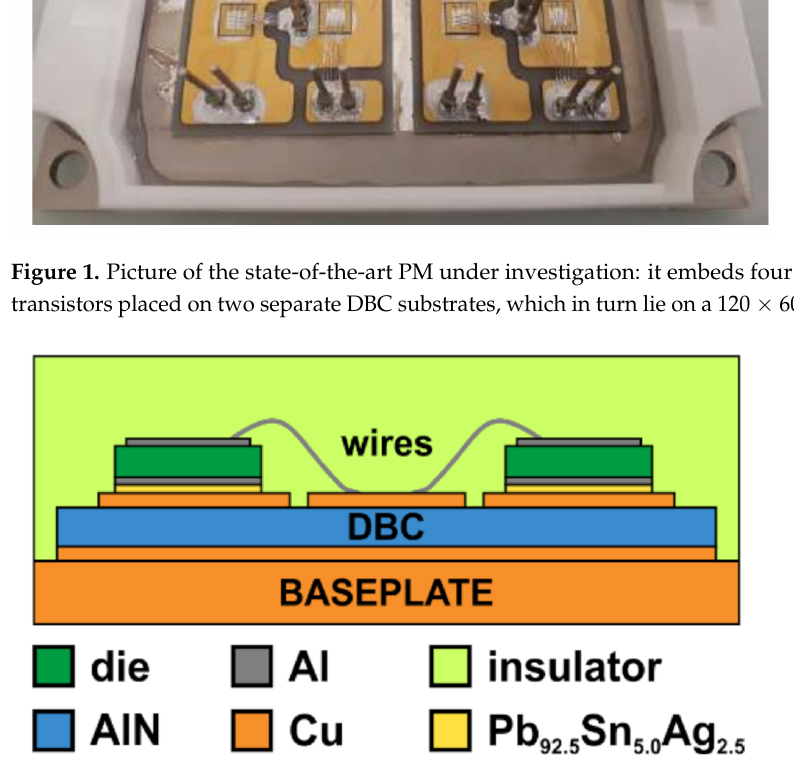
Figure 2. Schematic cross-section (not to scale) of the PM under investigation. The materials are identified by different colors. Evidenced are the Al wire bonds, the Cu baseplate, and the DBC substrate comprising Cu metallization and AlN